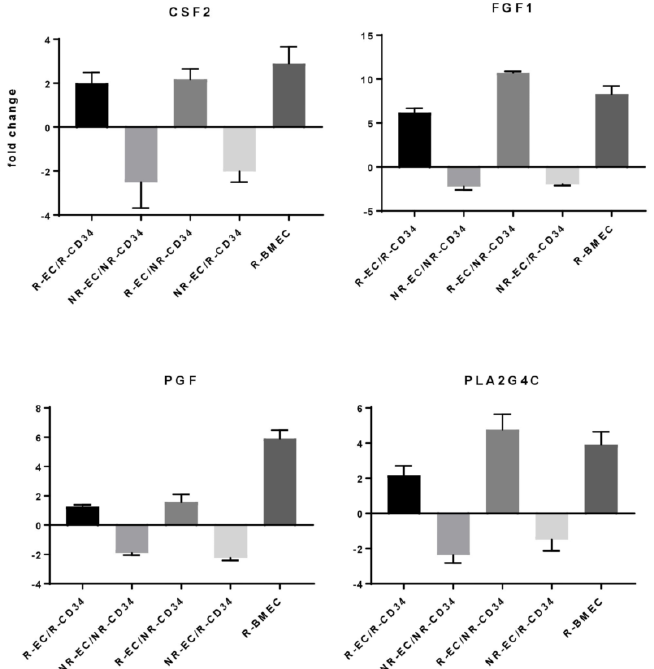
Figure 4. HSPC altered hBMEC gene response to MF radiation. Cells were irradiated with 6 Gy MF. HSPC were added to hBMEC and cocultured for 4 h. HSPC were removed, and RNA was isolated from hBMEC. Changes in gene expression were determined by RT-PCR array. Error bars represent standard deviation.